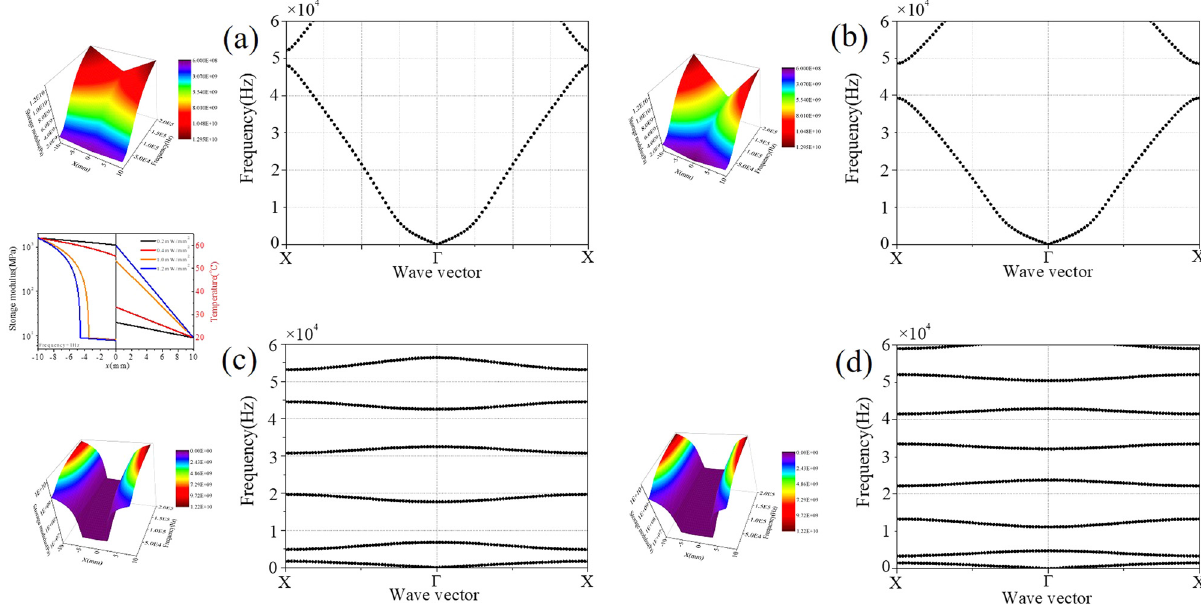
Figure 6: Band gaps of normal incident SH - waves with the heat fl ux of ( a ) 0.2 mW/mm 2 , ( b ) 0.4 mW/mm 2 , ( c ) 1.0 mW/mm 2 , and ( d ) 1.2 mW/mm 2 .